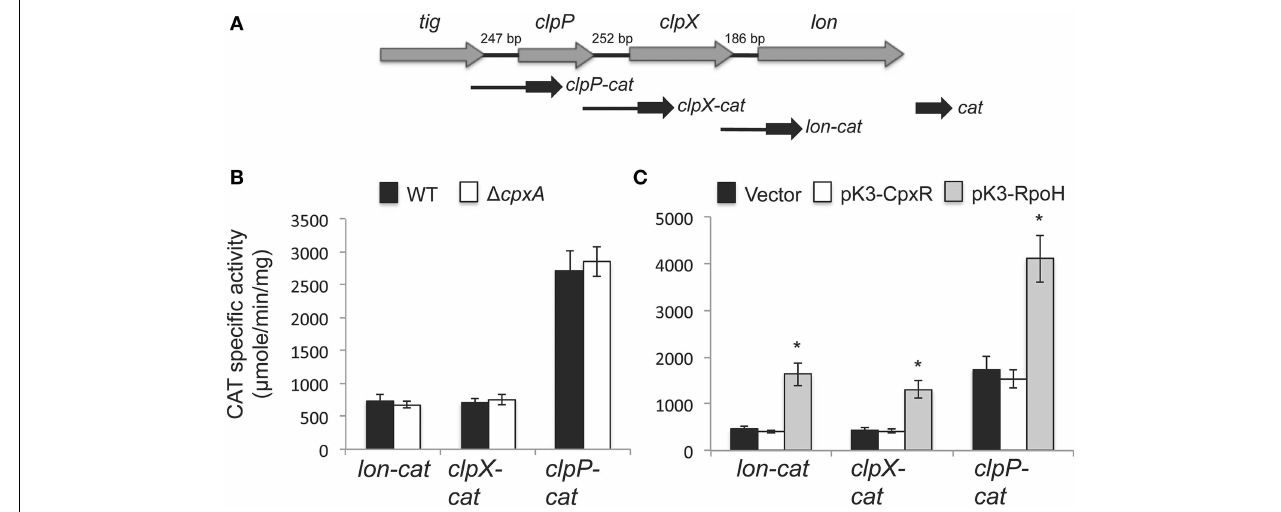
or pK3-RpoH, which constitutively express CpxR and RpoH, respectively, or carrying the vector pMPM-K3 (C) . CAT-specific activity was determined from samples collected of bacterial cultures grown for 5h in LB medium at 37 ◦ C. The data are the averages of three different experiments performed in duplicate. Bars represent the standard deviations. *Expression statistically different with respect to that shown by the same fusion in the WT strain containing the